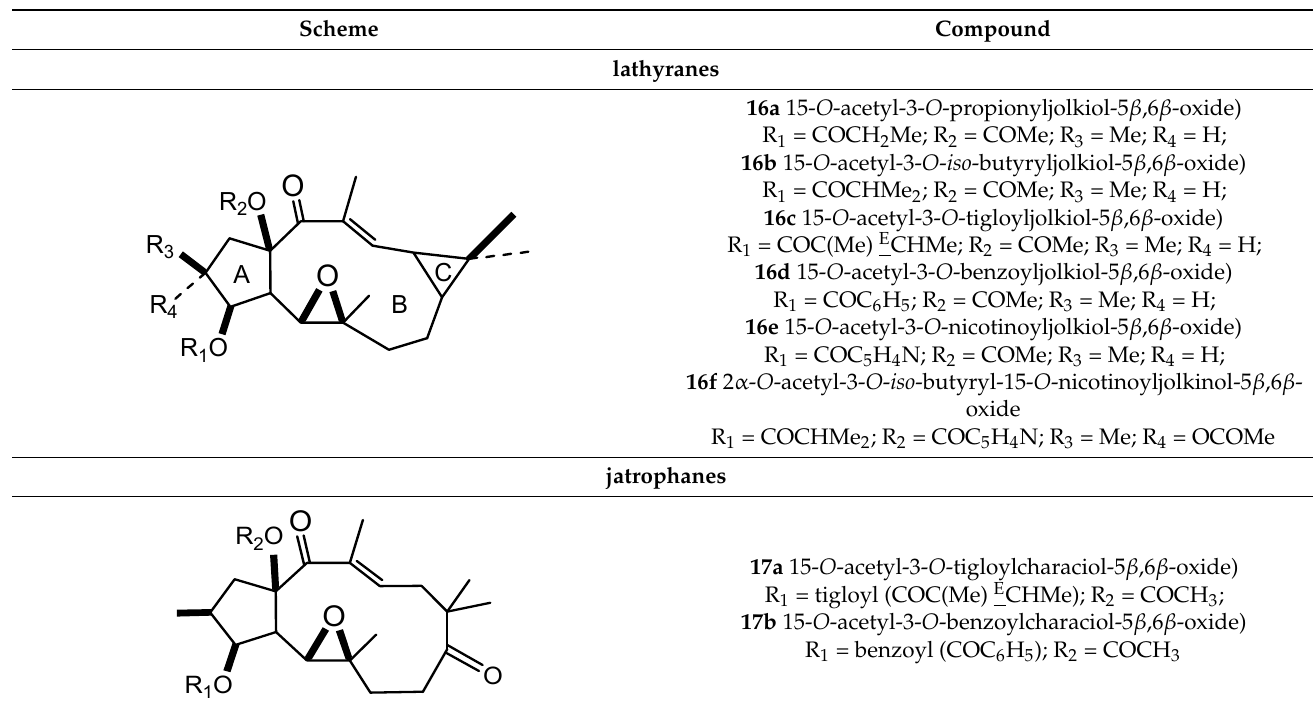
Table 2. Lathyranes and jatrophanes identified from E. characias latex (compounds 16a – f and 17a – f ) [19,20], roots (com- pounds 17g – h ) and whole plant (compounds 18a – l ) [21].